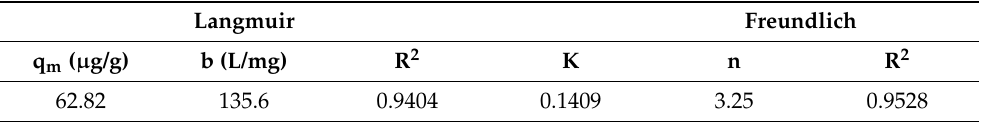
Table 3. Parameters of the Langmuir and Freundlich isotherm models for As(V) adsorption on Magnetic Xerogel Monoliths.